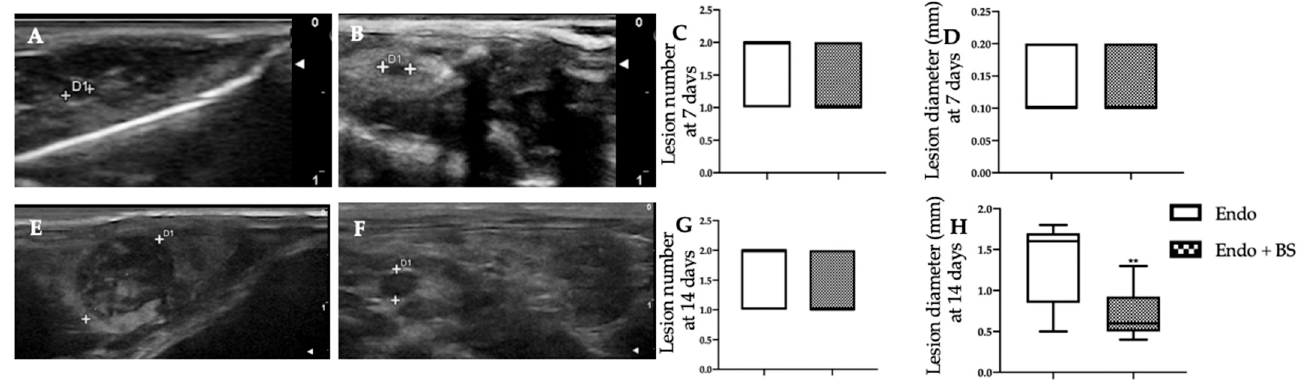
Figure 1. Analysis of endometriotic lesions development: high-frequency ultrasound analysis (hfUS) analysis at 7 days from the surgery: EMS ( A ), EMS + BS ( B ), lesion number ( C ), lesion diameter ( D ); hfUS analysis at 14 days from the surgery: EMS ( E ), EMS + BS ( F ), lesion number ( G ), lesion diameter ( H ). For the analyses, n = 5 animals from each group were employed. A p -value of less than 0.05 was considered significant. ** p < 0.01 vs. control.